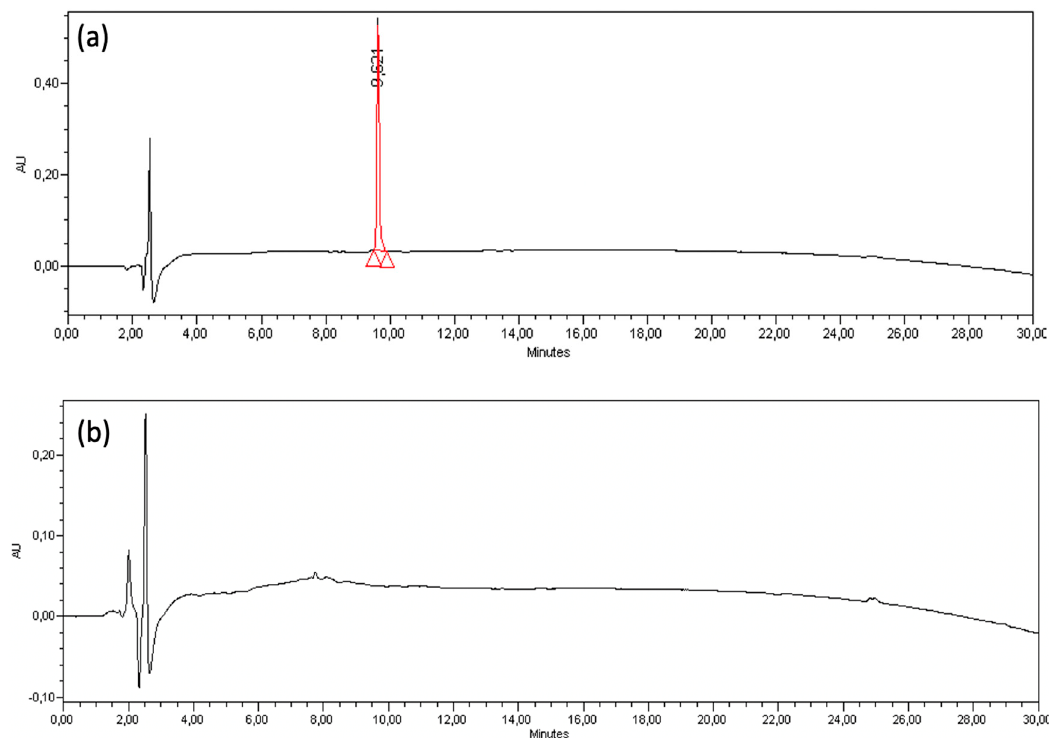
Figure 6. ( a ) High-performance liquid chromatography (HPLC) analysis of (KG) 5 -MOG 35-55 –214 nm at the beginning of the conjugation reaction and ( b ) HPLC analysis of OM-(KG) 5 -MOG 35-55 solution after 6 h.